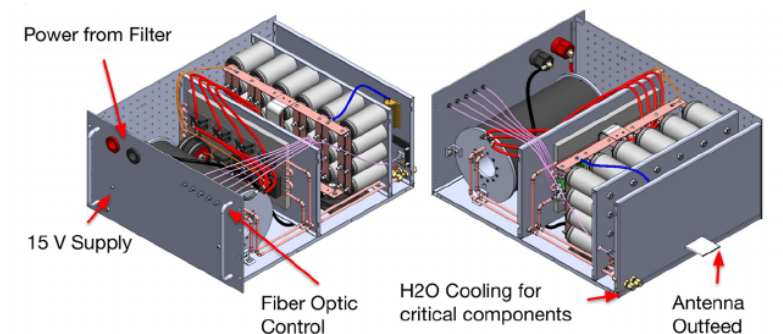
Figure 22. Mechanical design of a single PPU to supply power to one antenna in the UM 30kW RMF-FRC (from [43]; reproduced with permission of Electric Rocket Propulsion Society). The low-pass filter for protecting the input source from switching transients is not pictured.